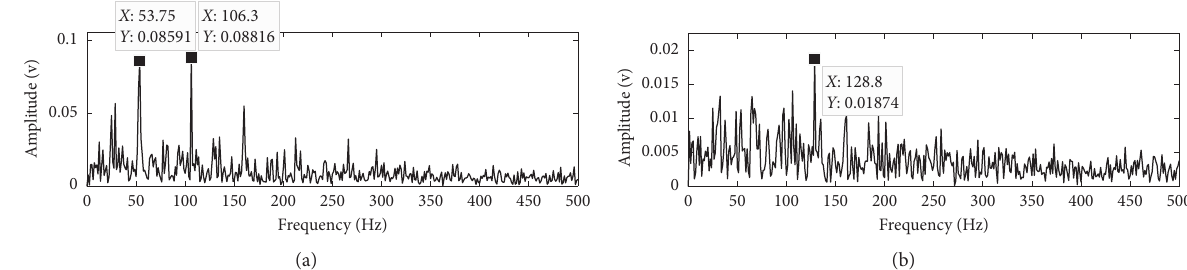
Figure 9: The envelope demodulation spectral analysis results of the signals as shown in Figure 8.